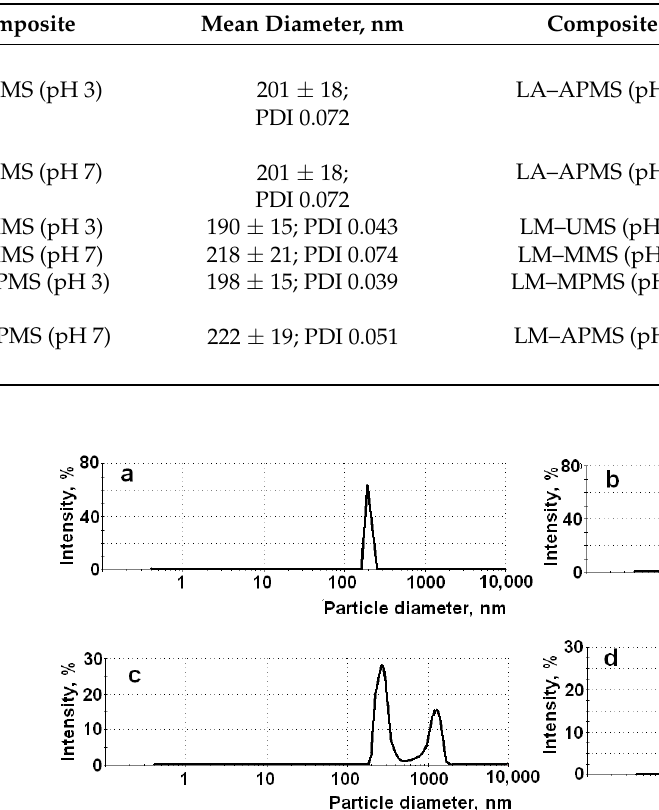
Table 3. Mean particle size of the synthesized composite.